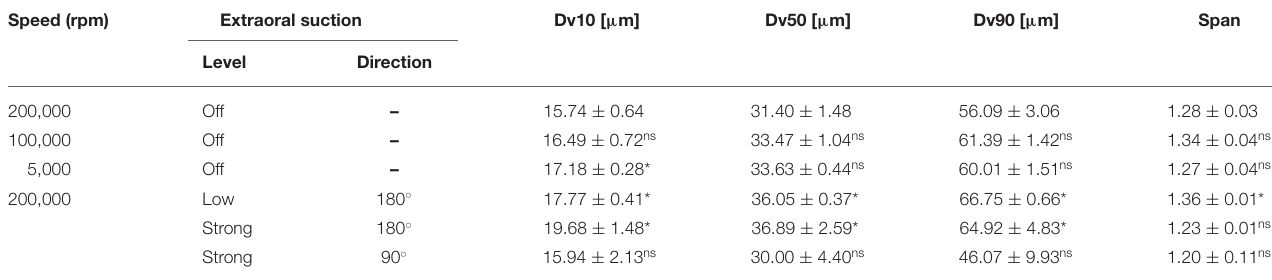
TABLE 2 | Numerical parameters of the droplet size distribution in the aerosol from the dental engine at the various speed and conditions of the extraoral suction through-cylinder group. Speed